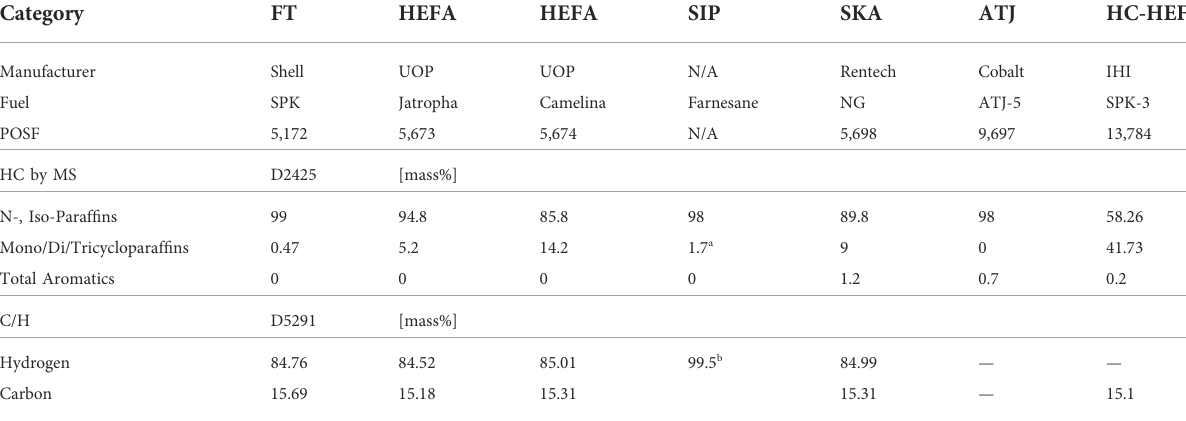
TABLE 2 Compositional analysis for neat